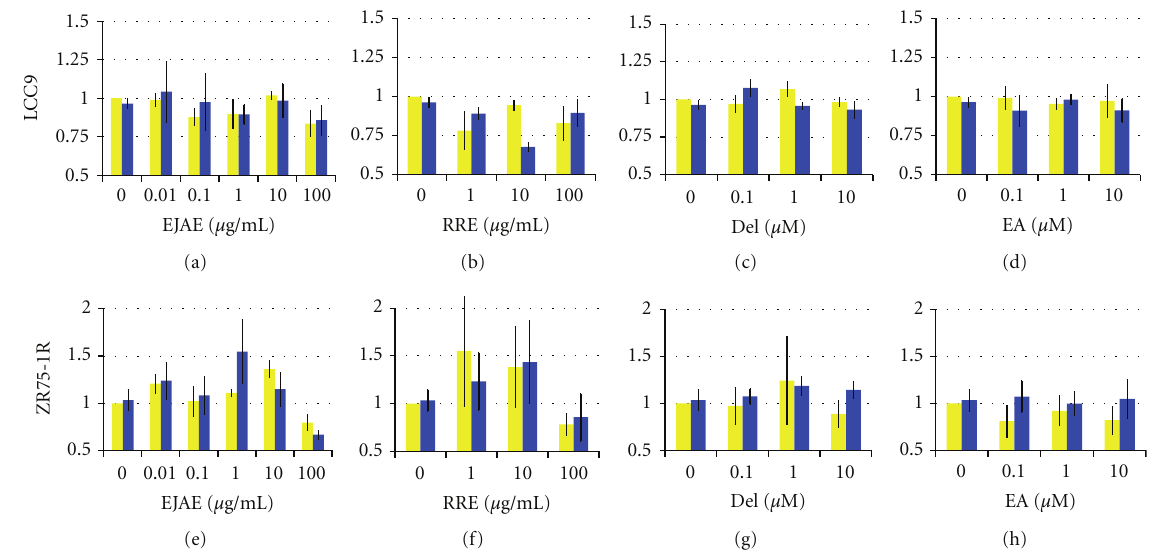
Figure 2: E ff ect of berry extracts and polyphenols on proliferation of ICI-resistant (LCC9 and ZR75-1R) cell lines. Cell proliferation results from 6d treatment of various cell lines with respective berry extract or polyphenol. Yellow (light) bars represent extract/polyphenol only and blue (dark) bars represent extract/polyphenol +1nM ICI. Each extract or polyphenol used for treatment was diluted 1000-fold from stock concentration. Vehicle treatment contained 0.01% EtOH and 0.1% DMSO. All treatments were normalized to the appropriate vehicle treatment. Data represented is mean ± standard error of three individual experiments performed in triplicate for each treatment. The means were tested for di ff erence using a t -test and a P ≤ 0 . 05 considered